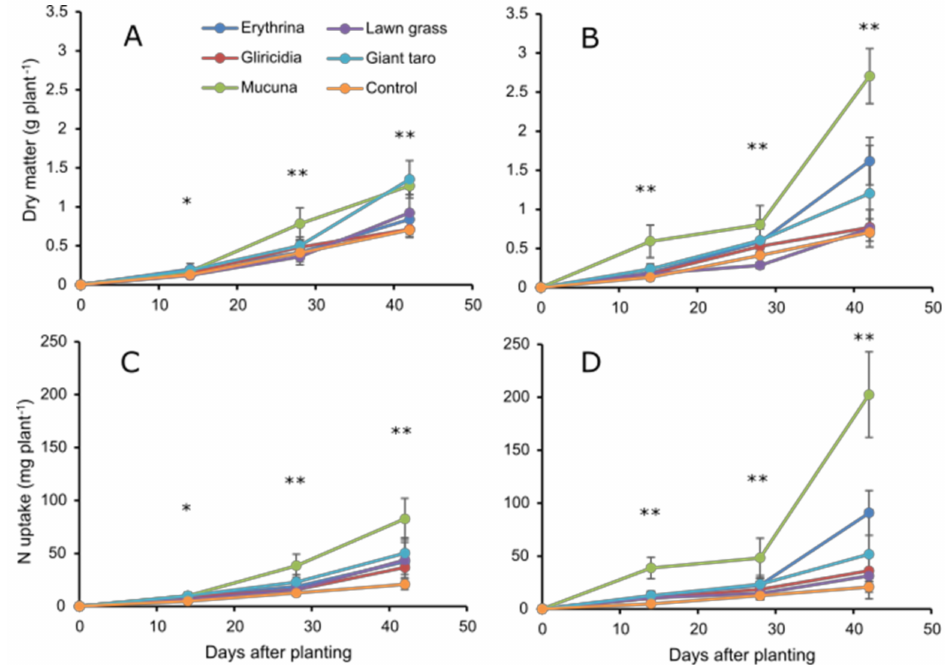
Figure 5. Dry matter accumulation (g plant − 1 ) ( A , B ) and total N uptake (mg N plant − 1 ) ( C , D ) in Chinese cabbage over time as influenced by different organic amendments applied with 10 ( A , C ) and 20 t ha − 1 ( B , D ) (*, ** indicate significant at the 0.05 and 0.01 probability levels, respectively; vertical bars represent standard